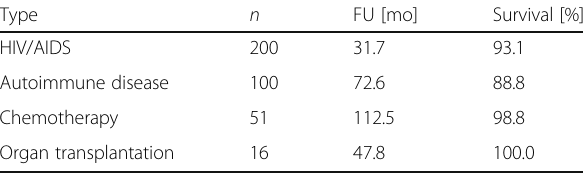
Table 2 Pooled survival rates and medical